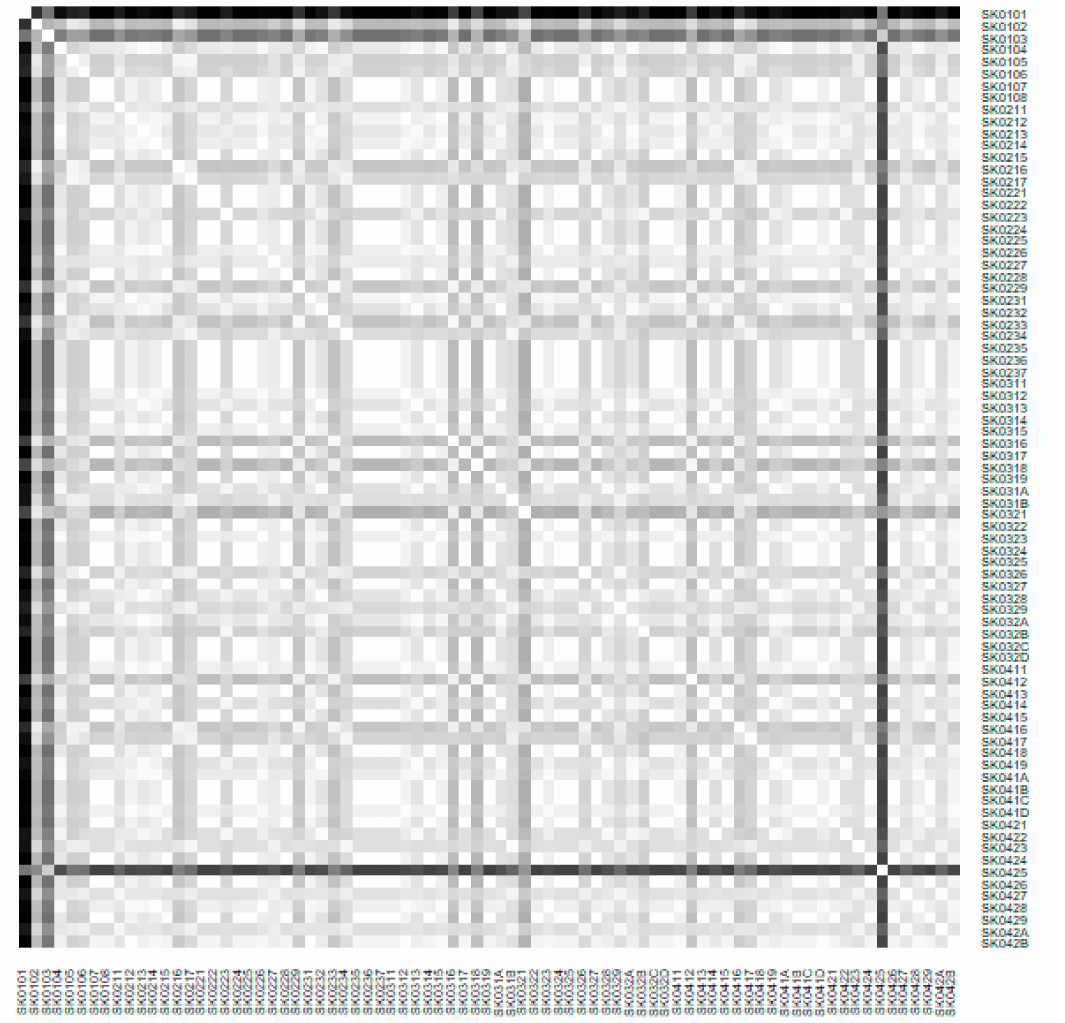
Figure 4. Medical equipment heat map of the districts in the year 2015. Source: own elaboration by the authors.